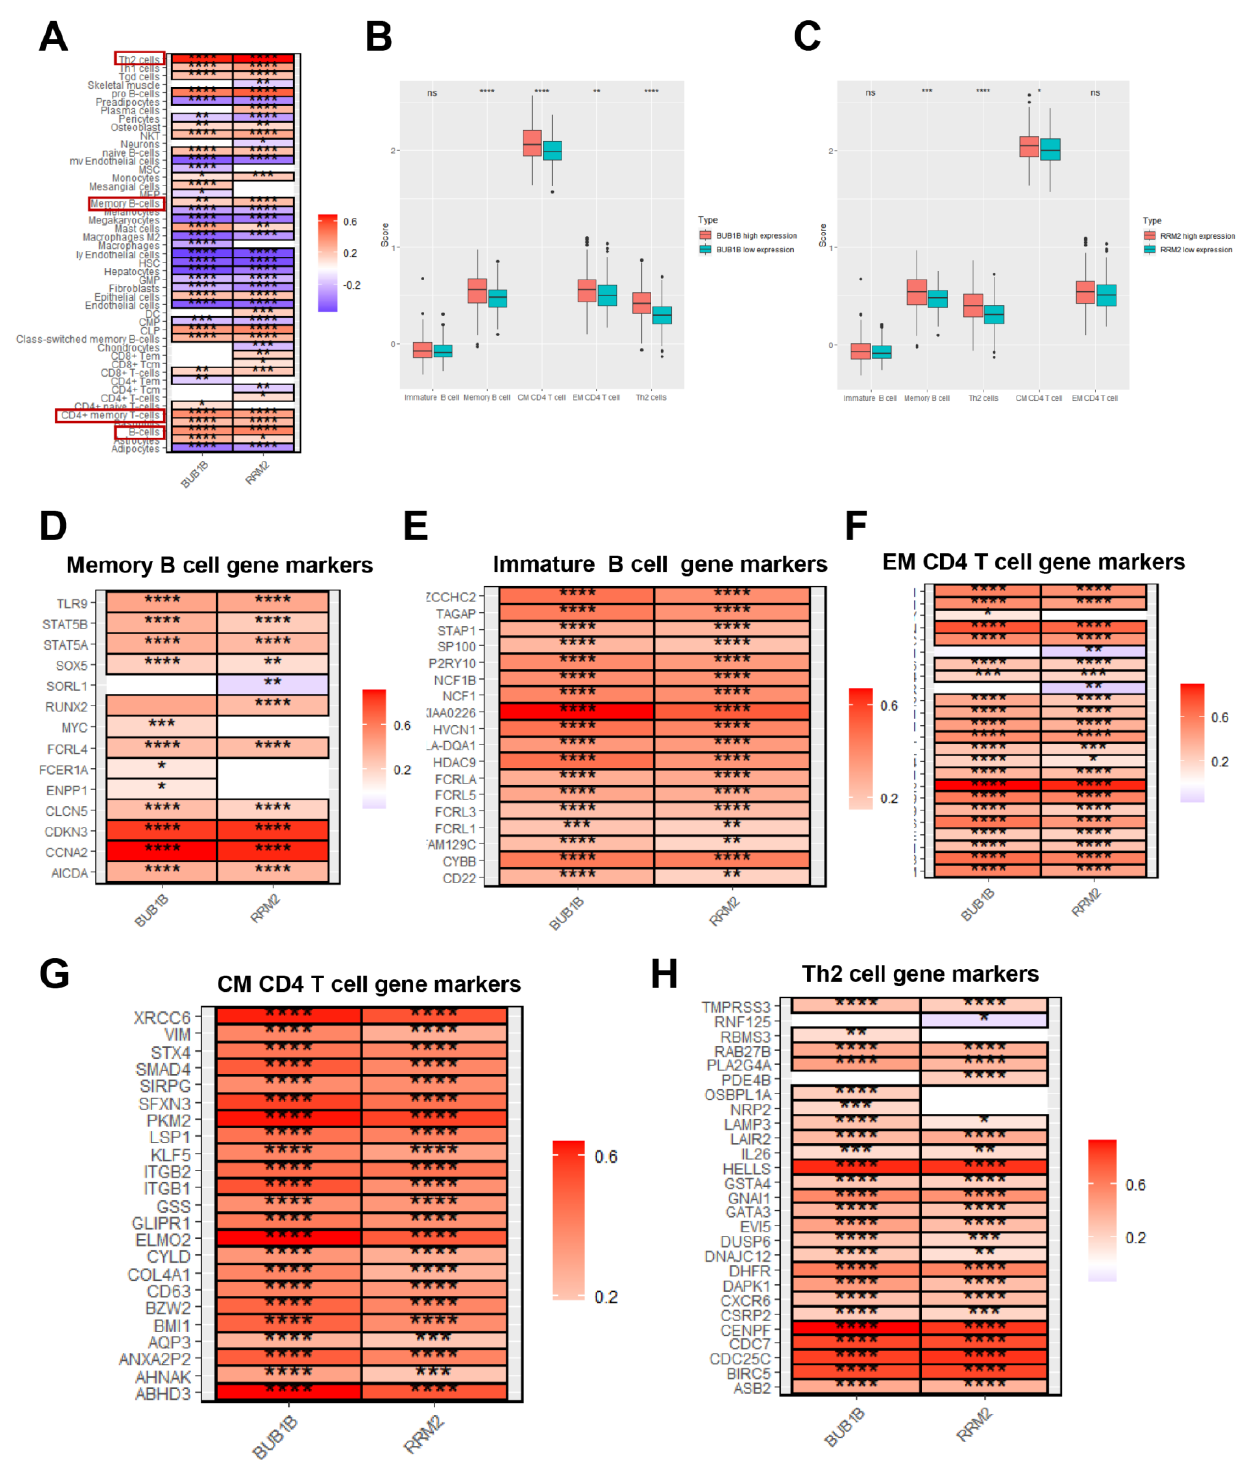
Figure 4. BUB1B and RRM2 are related to immune cell infiltration. ( A ) The correlation between immune cell infiltration and the expression of BUB1B and RRM2 in TCGA-LIHC cohort. ( B ) Comparison of ssGSEA scores between BUB1B high expression group and BUB1B low expression group in TCGA-LIHC cohort. ( C ) Comparison of ssGSEA scores between RRM2 high expression group and RRM2 low expression group in TCGA-LIHC cohort. ( D – H ) The correlation between memory B cells immune markers, immature B cells immune markers, effector memory CD4+ T cell immune markers, central memory CD4+ T cell immune markers, and Th2 cell immune markers with the expression of BUB1B and RRM2. * p < 0.05; ** p < 0.01; *** p < 0.001; **** p <